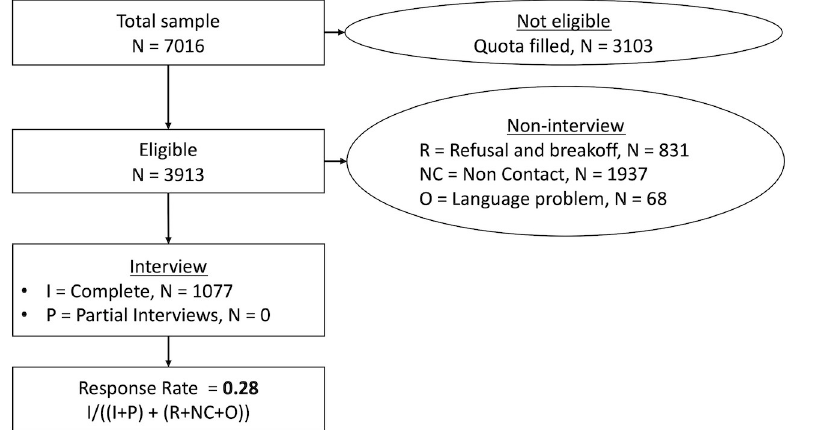
Fig 1. Study recruitment flowchart and response